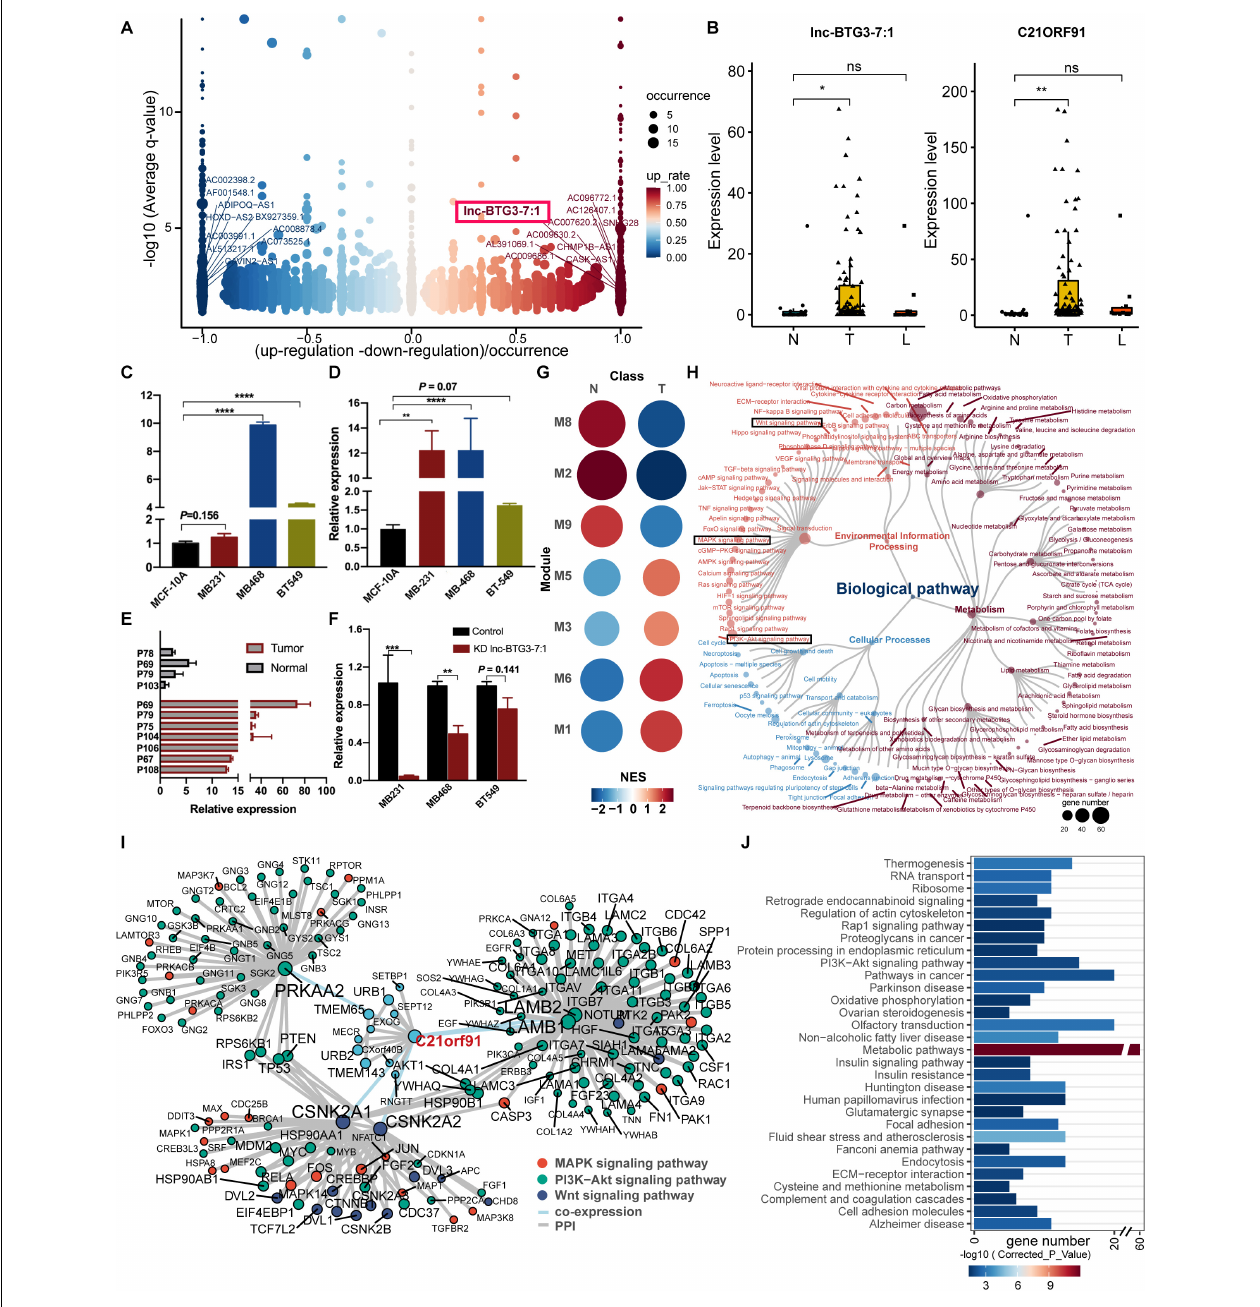
FIGURE 2 | Identification of functional LncRNA and targeted genes potentially driving TNBC progress. (A) Differential expression of lncRNAs in TNBC biopsies. DE-lncRNAs were ranked by fold change and occurrence. The ten up- and down-expressed lnc-RNAs were labeled. Lnc-BTG3-7:1 was highlighted with a red frame in the up-regulated group. (B) The expression level of Lnc-BTG3-7:1 in TNBC biopsies ( n = 113) was higher than normal breast tissue ( P < 0.005***), accompanied by the C21ORF91 gene expression increased ( P < 0.005***). (C,D) The abundance of Lnc-BTG3-7:1 (C) and C21ORF91 (D) highly increased in TNBC cells compared to MCF10A ( P < 0.05). (E) A total of seven TNBC tumor tissue samples and four normal breast tissue samples were tested by qPCR, and a remarkably higher expression of Lnc-BTG3-7:1 in tumor tissues was showed compared to normal tissues ( P < 0.005***). (F) Knockdown of lnc-BTG3-7:1 suppressed the C21ORF91 gene expression in MDA-MB-231 ( P < 0.005***) and MDA-MB-468 ( P < 0.005**), respectively. (G) Gene set enrichment analyses showing the module activity in tumor tissues and adjacent normal tissues. Point size and color represented the normalized enrichment score (NES). (H) Functional annotation based on KEGG functional hierarchy for genes in module M3. Node size represented the number of genes or children terms. Node color indicated the functional classification of pathways. (I) Interaction network suggested a pivotal role of Lnc-BTG3-7:1 and C21ORF91 in TNBC progress via coordinating oncogenic signaling. The genes involved in Wnt/ β -catenin, Ras/MAPK, and PI3K/AKT pathways were color-marked. (J) Over-representation analysis of co-expressed genes of C21ORF91 . The bar chart showed the gene number in the corresponding pathway. The color of the bar indicated the statistical significance. * P < 0.05 and *** P < 0.001.